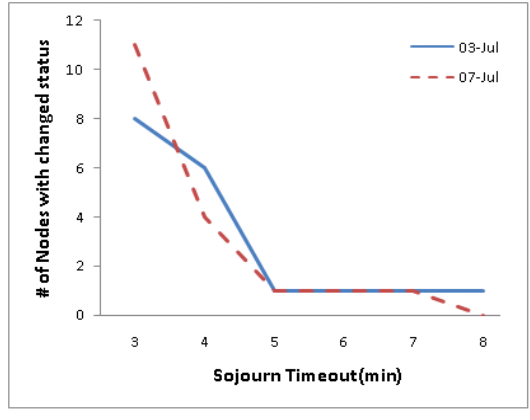
Figure 9. Number of nodes with changed status from inside to outside for different STOs.